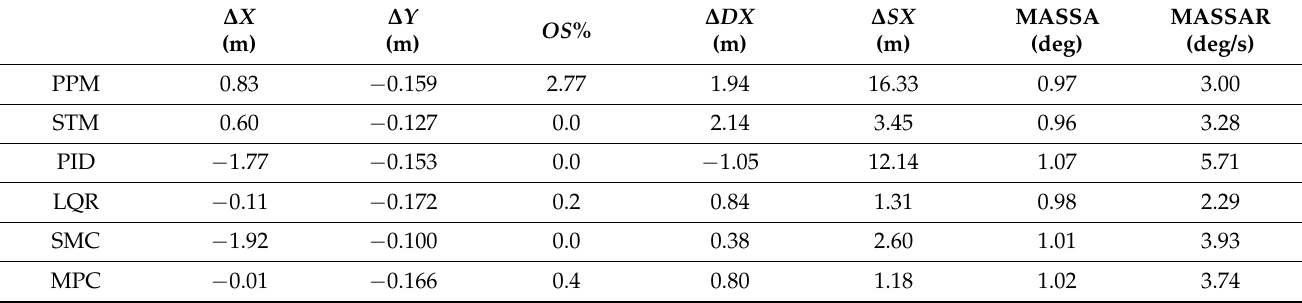
Table 8. Summary of simulation results of each controller for FWS vehicle in the fourth set of